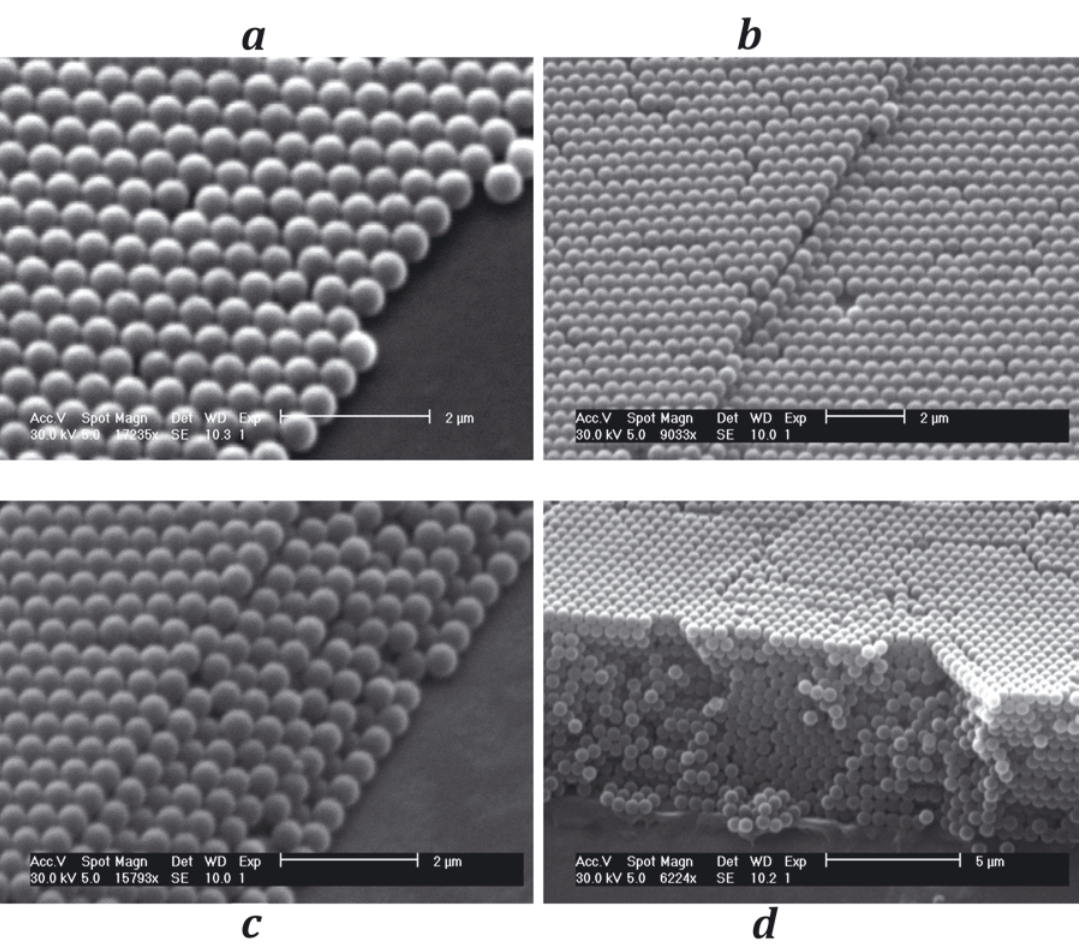
Figure 1. SEM images of templates made from polystyrene spheres of 500 nm diameter and have different number of layers (a) monolayer, (b) two layers, (c) 7 layers and (d) 15